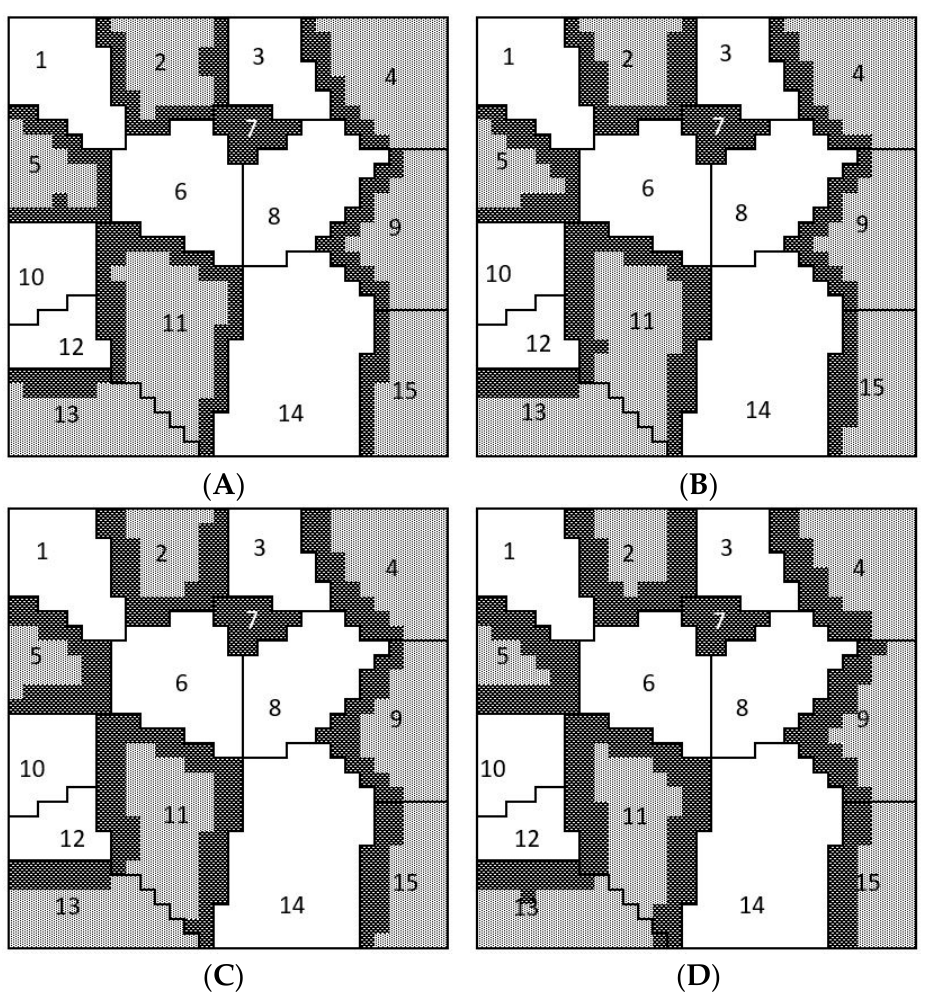
Figure 5. GM, non-GM fields, and buffers. Non-GM producers have the property rights, and buffers are created in the GM fields. From top to bottom and from left to right are the 5% ( A ), 1.5% ( B ), 0.9% ( C ), and 0.25% ( D ) thresholds. GM fields are represented with the light grey patterns, buffers are the dark-grey patterned areas, and white areas are the non-GM fields.